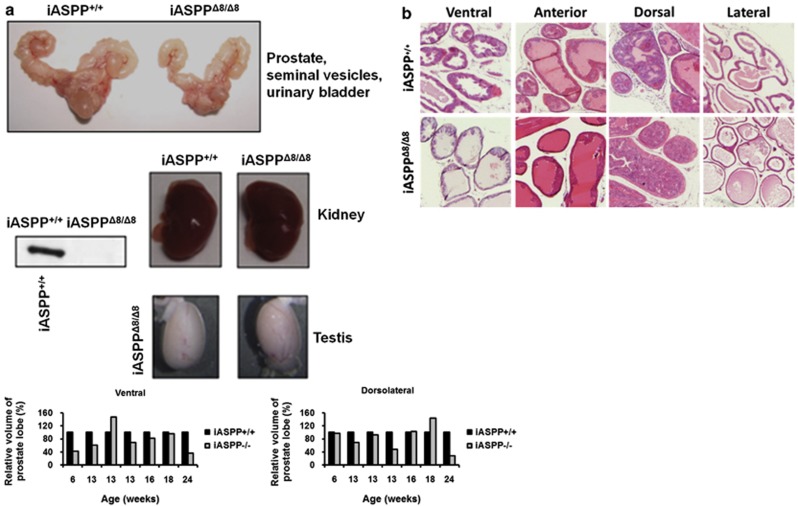
Phenotypic analysis of iASPPΔ8/Δ8 mouse prostates. (a) The prostate glands of iASPPΔ8/Δ8 mice were macroscopically similar to those of wild-type mice. (b) iASPPΔ8/Δ8 mouse prostate lobes developed with an intact epithelial lining and a lumen. (c) iASPPΔ8/Δ8 mouse (n=3) prostate lobes demonstrated a small reduction in the number of Ki67-positive actively proliferating epithelial cells compared with iASPP+/+ (n=3) controls. (d) iASPPΔ8/Δ8 (n=4) mice demonstrated a small reduction in the number of BrdU-labelled cells in each lobe of the prostate following BrdU injection compared with iASPP+/+ (n=3) controls. (e) iASPPΔ8/Δ8 mice (n=5) demonstrated a small reduction in the number of TUNEL-positive apoptotic epithelial cells in each lobe of the prostate compared with iASPP+/+ (n=5) controls. (f) iASPPΔ8/Δ8 mice (n=5) had significantly fewer p63-positive basal epithelial cells compared with iASPP+/+ mice (n=5). The expression level of TP63 in prostate protein extracts from iASPPΔ8/Δ8 mice was diminished compared with iASPP+/+ controls